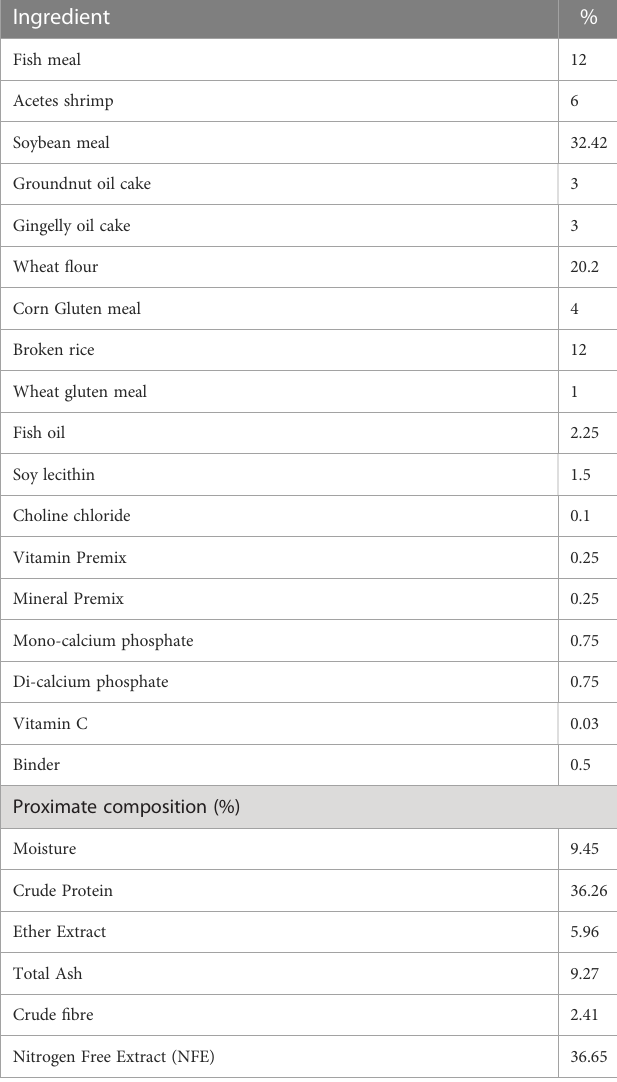
TABLE 1 Ingredient and proximate composition of the experimental feed provided during nursery and grow-out period of Indian white shrimp in